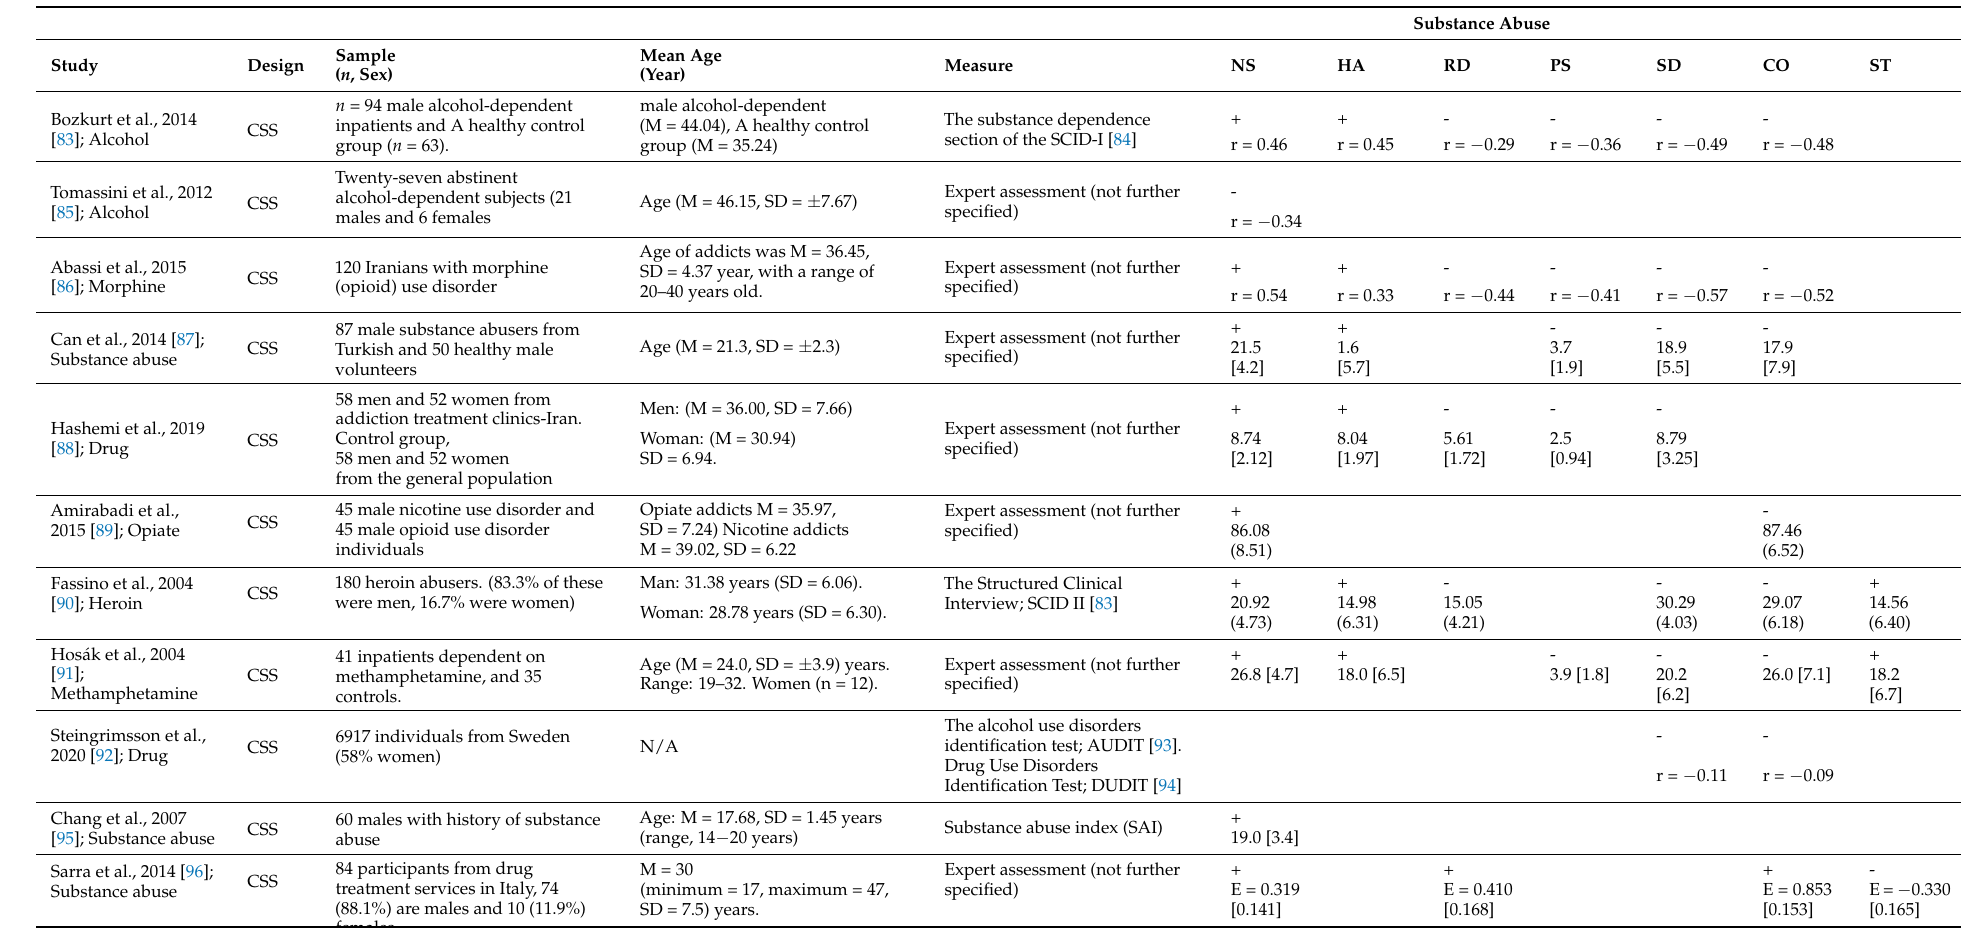
Table 2. Temperament traits (TCI; Temperament and Character Inventory) on CSBD and substance